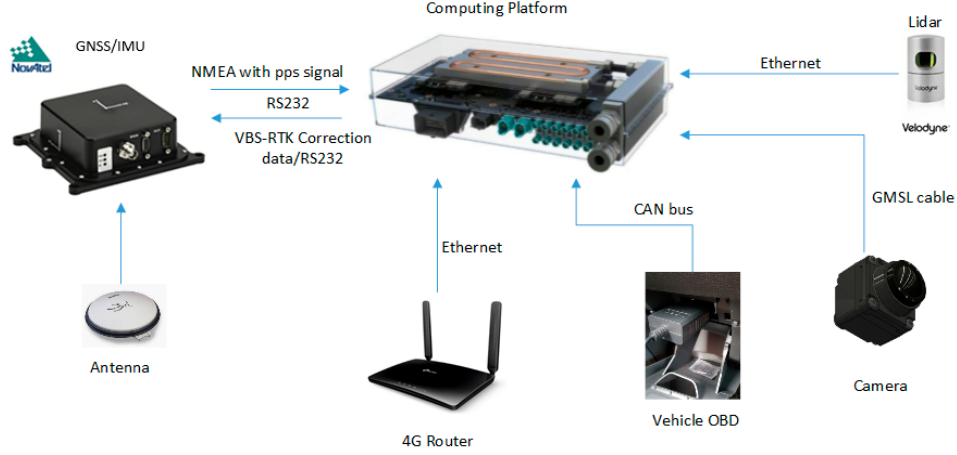
Figure 4. Hardware architecture of the proposed MMS.